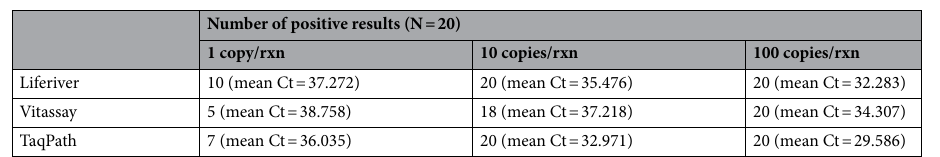
Table 3. Sensitivity of the studied RT-qPCR assays determined by analysis of twenty replicates of samples representing 1–100 copies of viral RNA per reaction. Mean Ct values corresponding to the respective copy numbers are given in